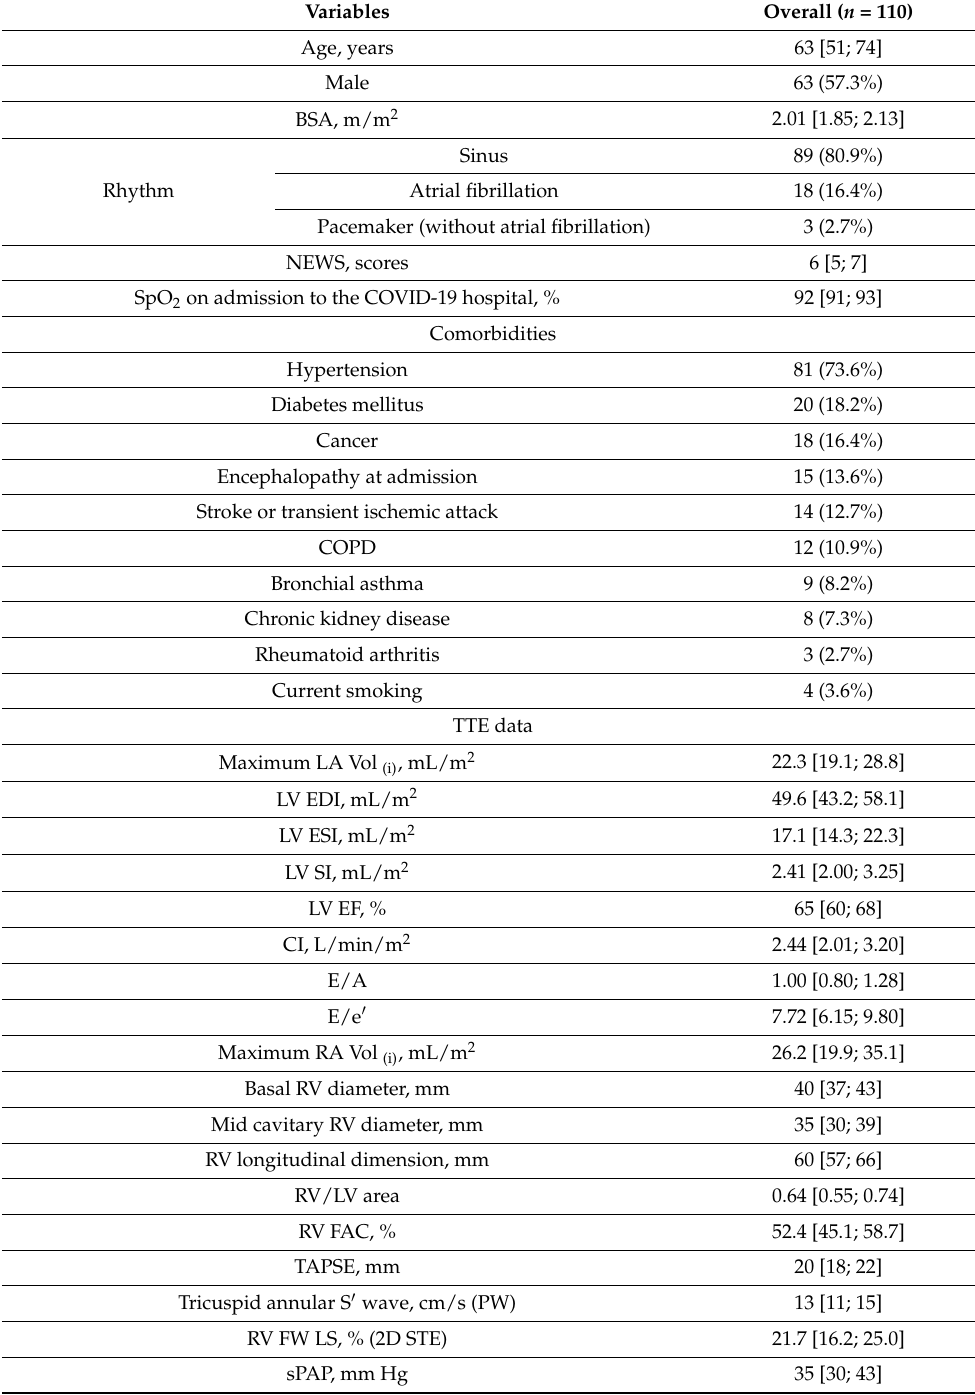
Table 1. Clinical characteristics and TTE characteristics of the overall cohort of patients with